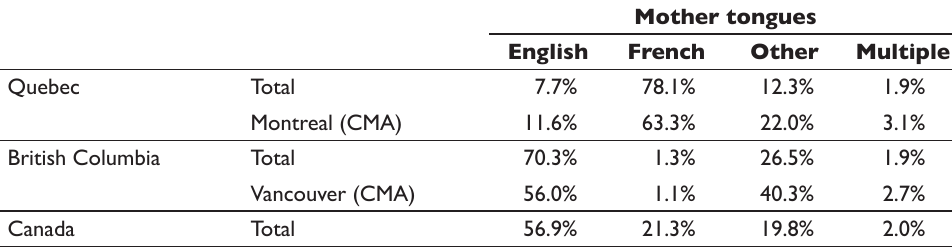
Table 1: Mothertonguebyprovincesandcensusmetropolitanarea(CMA)